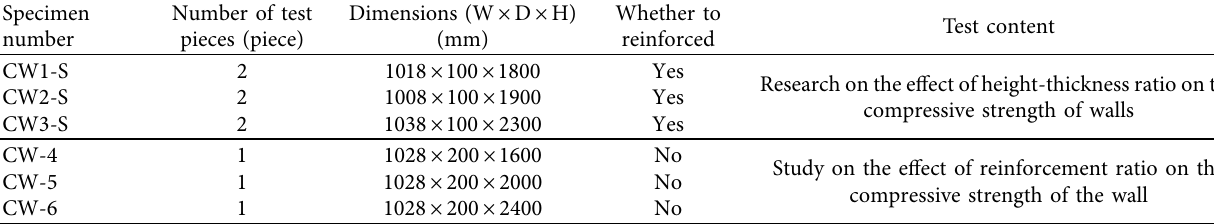
Table 1: Specimen design